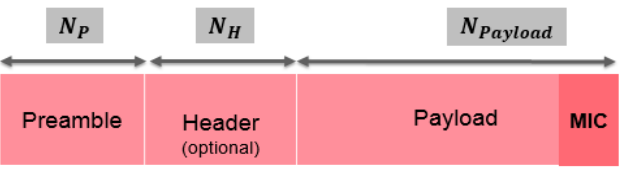
Figure 6. LoRa ACK